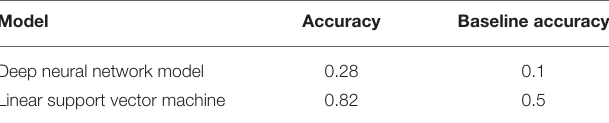
TABLE 1 | Comparison of the performance of the deep neural network model and the binary